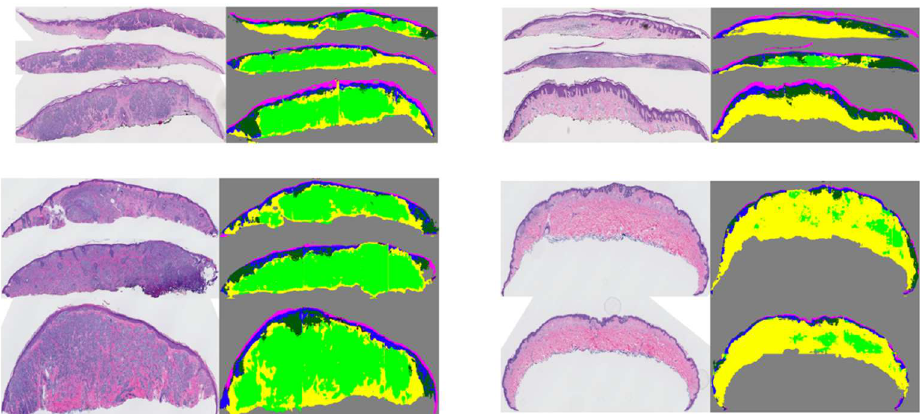
Figure 4. Examples of original WSIs and their corresponding segmentation mask. The segmentation images contain the dermis, epidermis, stratum corneum, background, dermal, and epidermal nests. The model was trained on coarse and sparse annotations.